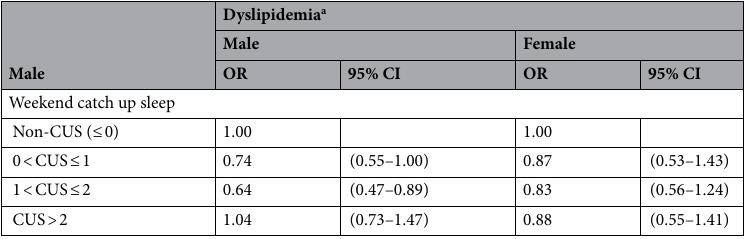
Table 4. Result of interesting subgroup analysis according to Catch up sleep level. a One of the following four criteria was required: (1) total cholesterol ≥ 240 mg/dL, (2) HDL cholesterol ≤ 40 mg/dL, (3) LDL cholesterol ≥ 160 mg/dL, or (4) triglycerides ≥ 200